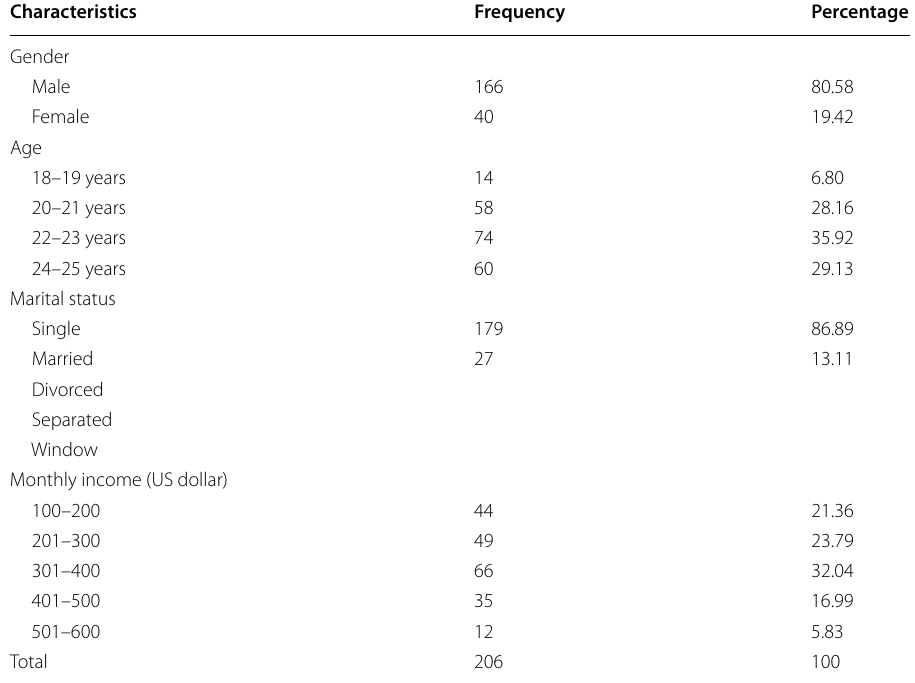
Table 3 Respondent’s demographic profile